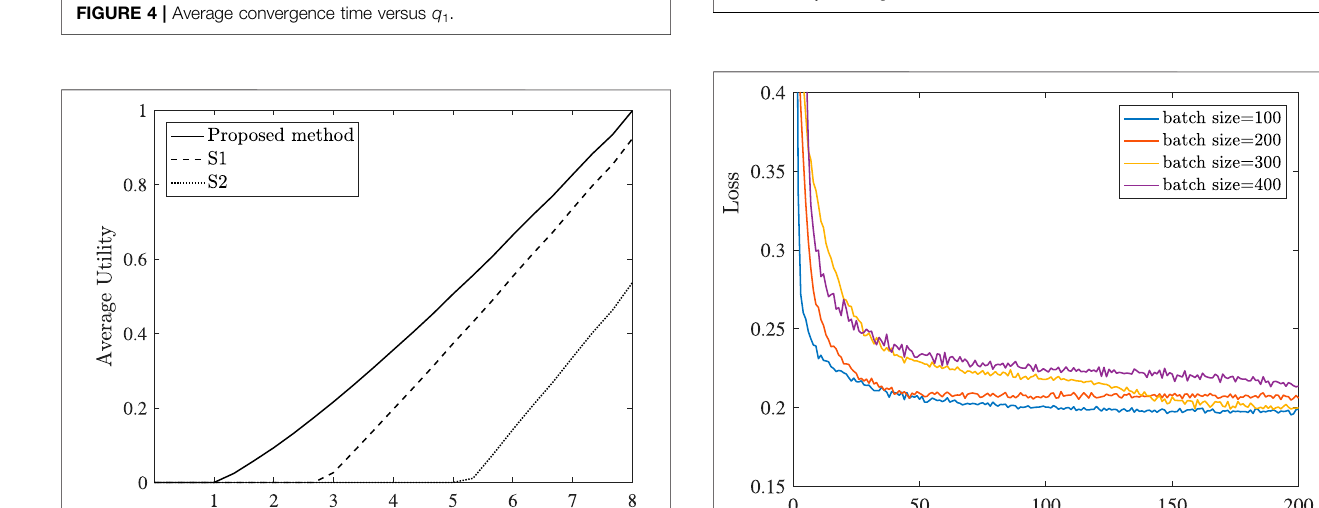
FIGURE 6 | Learning rate selection.